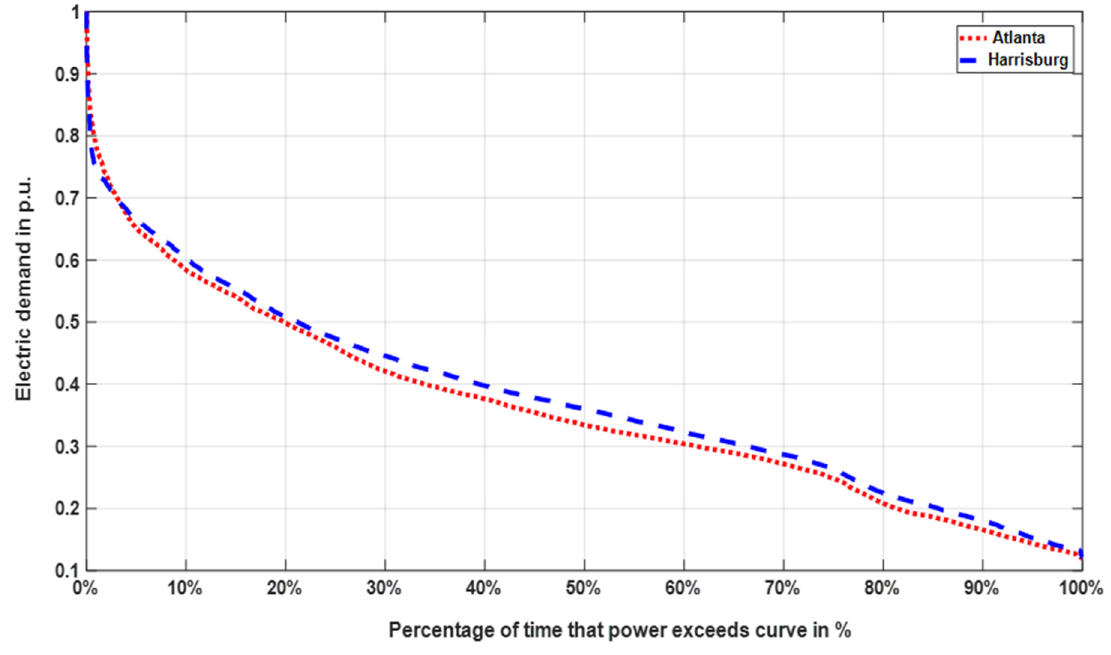
Figure 6. Comparison of electric demand over one year in Atlanta and Harrisburg, USA.